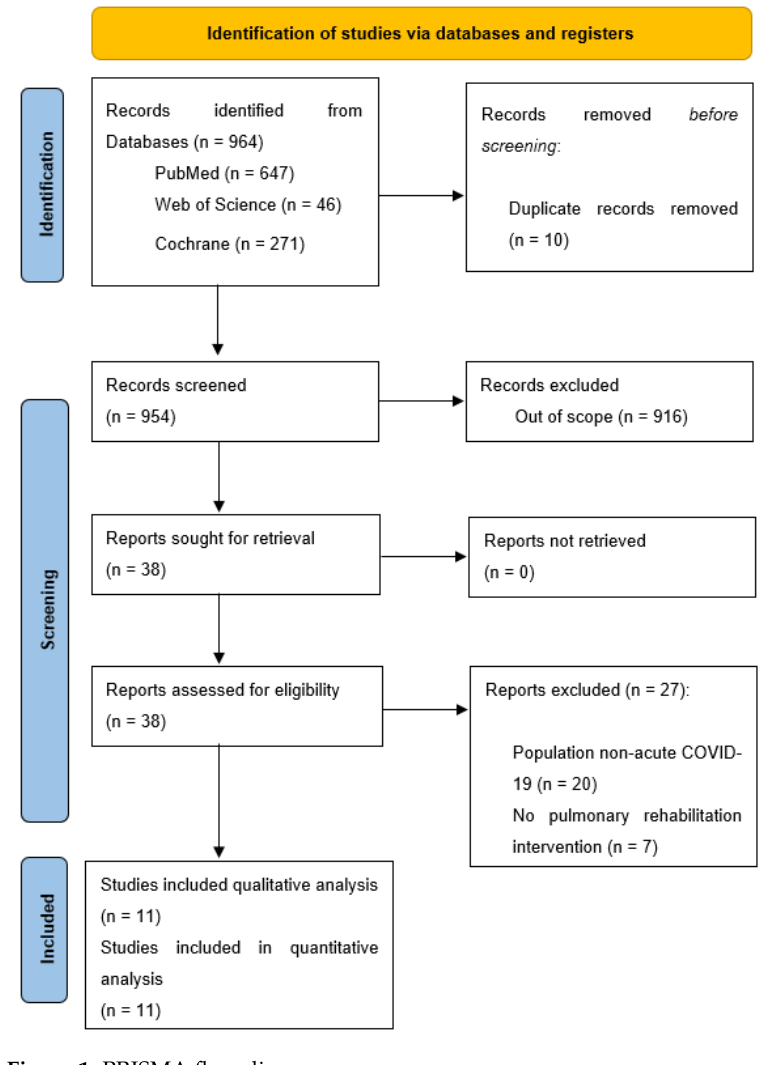
Figure 1. PRISMA flow diagram.